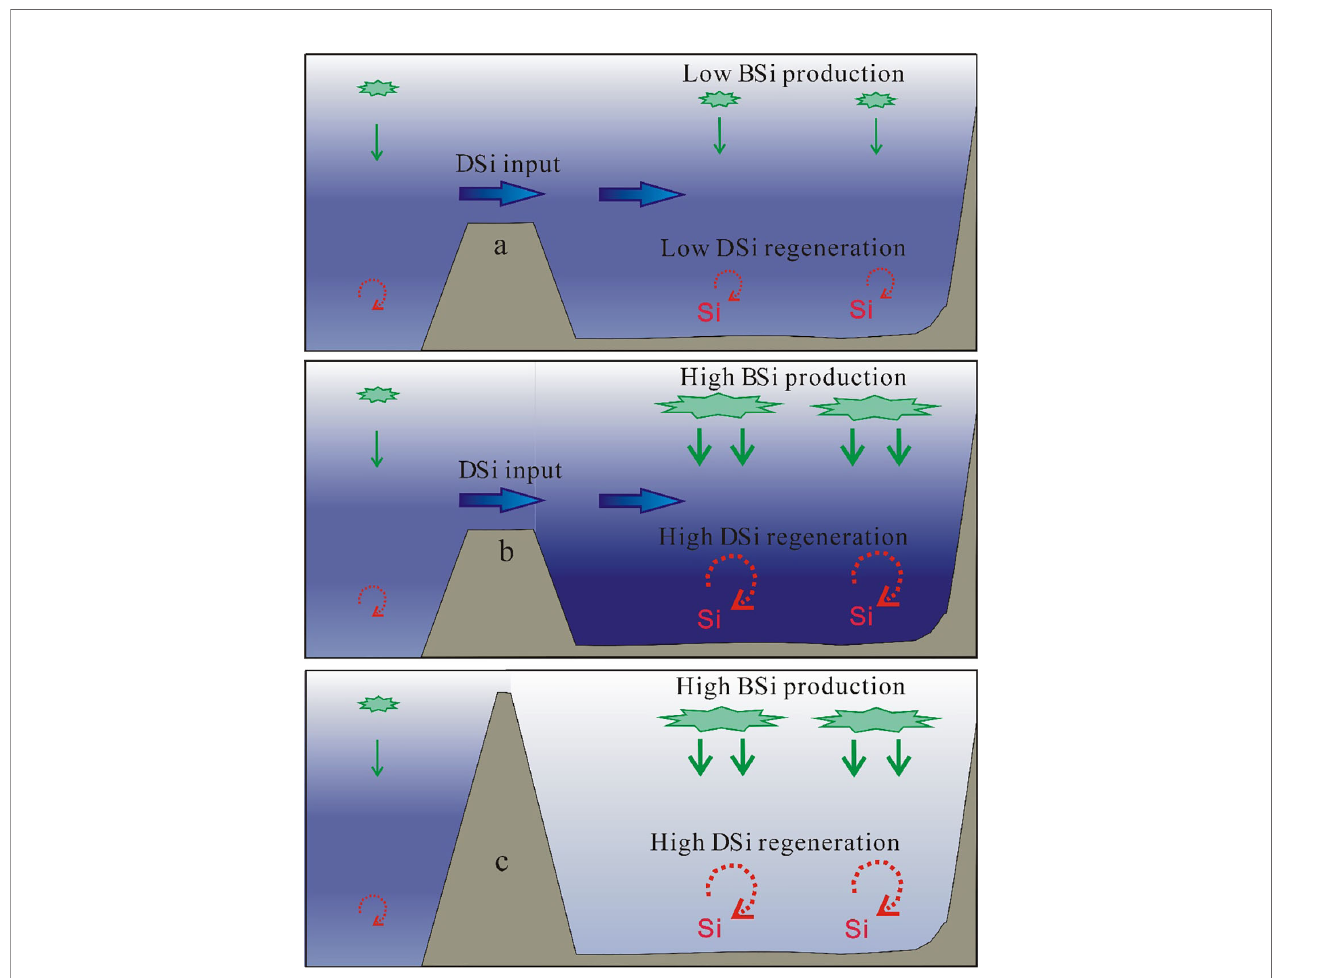
FIGURE 5 | Schematic diagrams showing the silica cycle in different marginal sea settings. (A) Oligotrophic marginal sea under the in fl uence of open ocean in fl ow water; (B) productive marginal sea under the in fl uence of open ocean in fl ow water; (C) marginal sea unaffected by open ocean in fl ow water. The background color indicates the concentration of DSi, with darker colors indicating higher